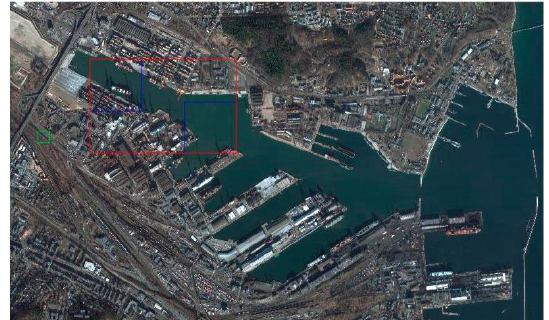
Figure 12. Detection on Gdynia Port in Poland by SIFT-based